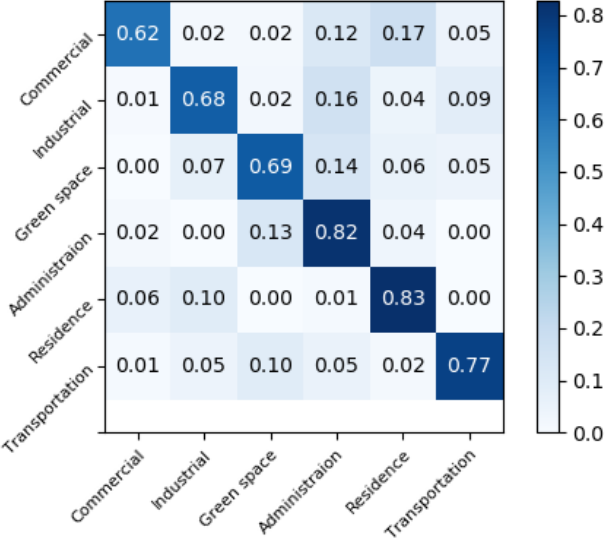
Figure 9. The training curve of the model. The training curve of the model. With the increase of epochs, the loss decreases gradually, and the accuracy of the model is improved.